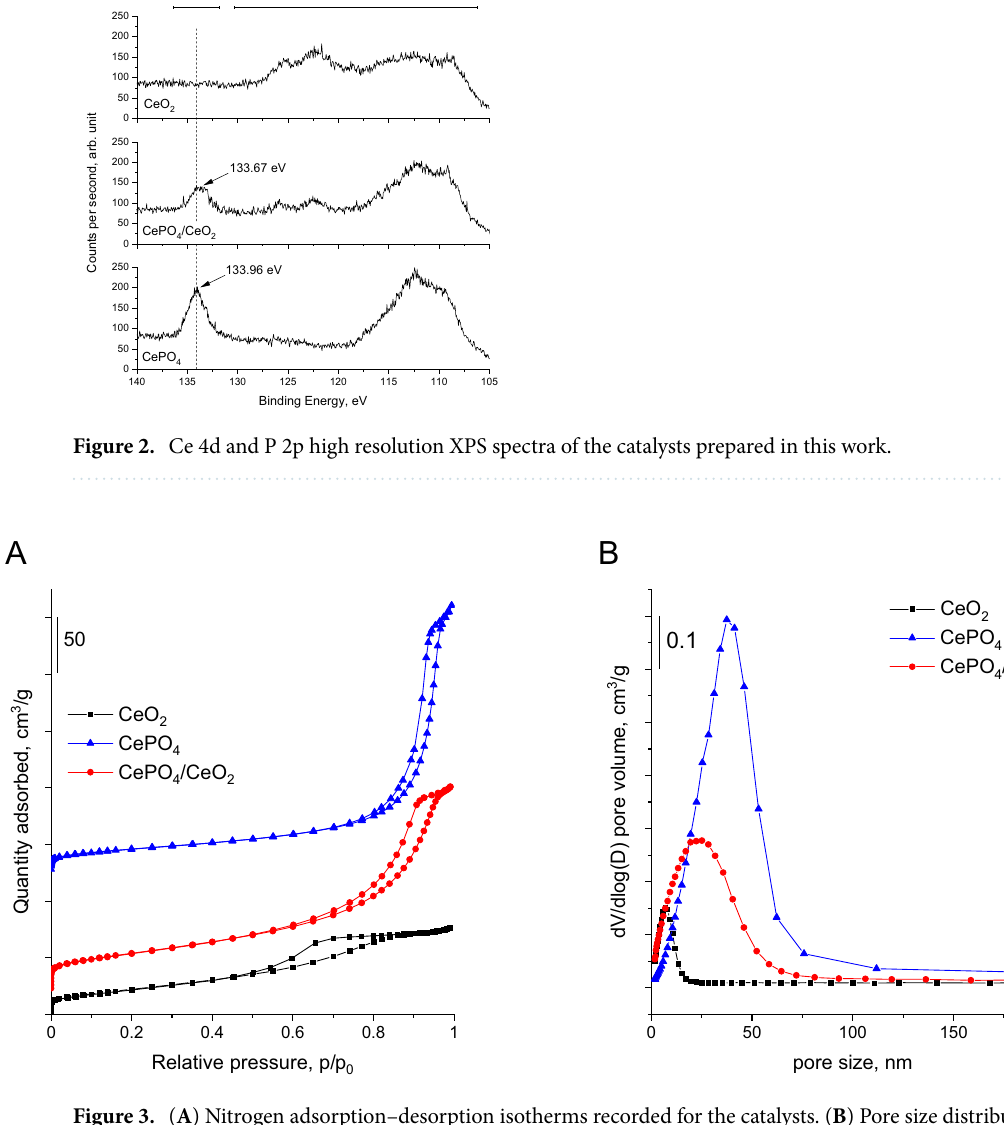
Figure 3. ( A ) Nitrogen adsorption–desorption isotherms recorded for the catalysts. ( B ) Pore size distribution estimated for the catalysts from the adsorption branches of isotherms using BJH